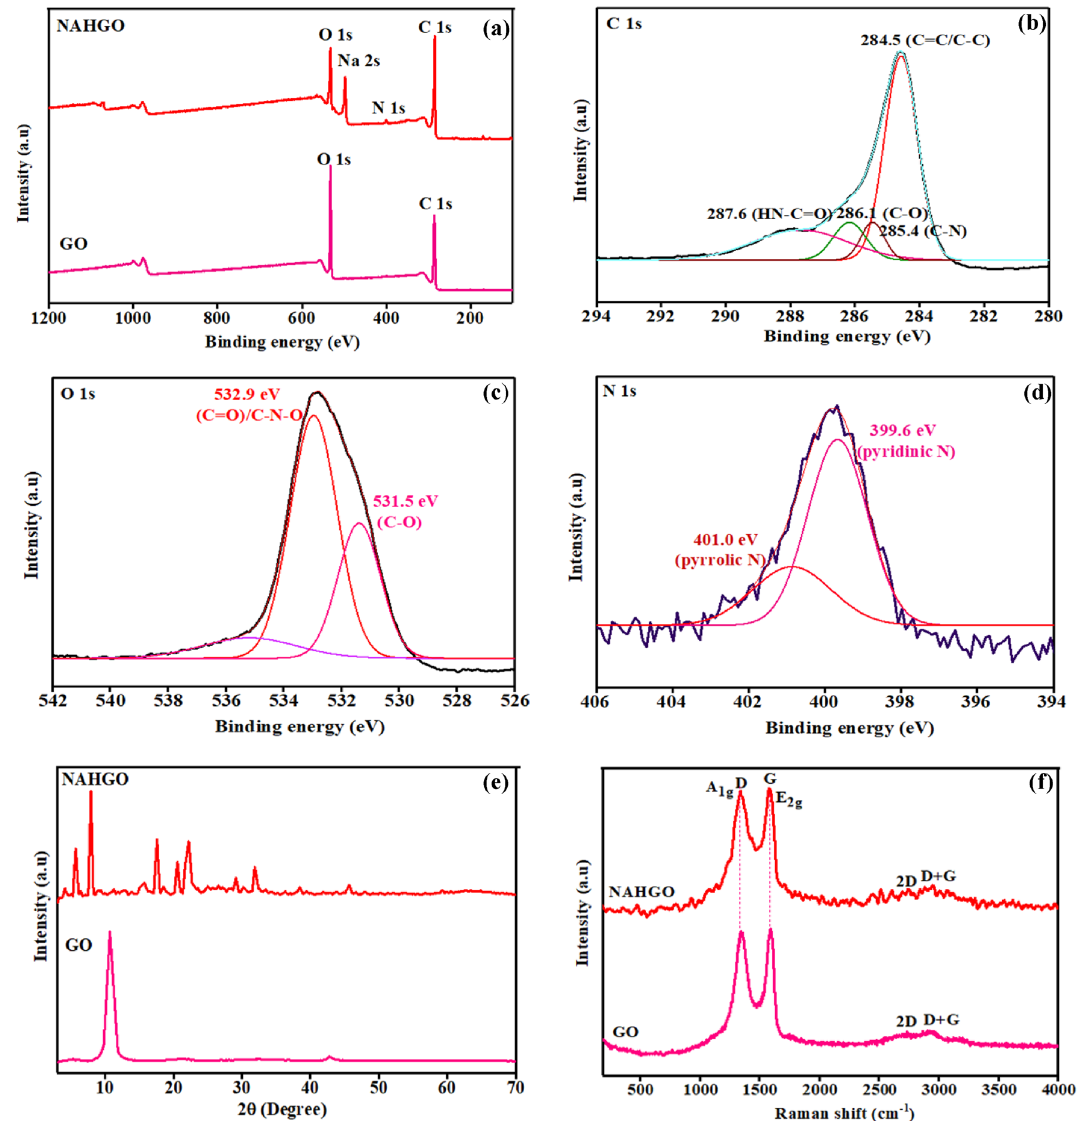
Figure 1. ( a ) XPS wide scan spectra of GO and NAHGO, deconvoluted peaks of ( b ) C1s, ( c ) O1s, and ( d ) N1s ( e ) Powder XRD patterns, and ( f ) Raman spectra of GO and